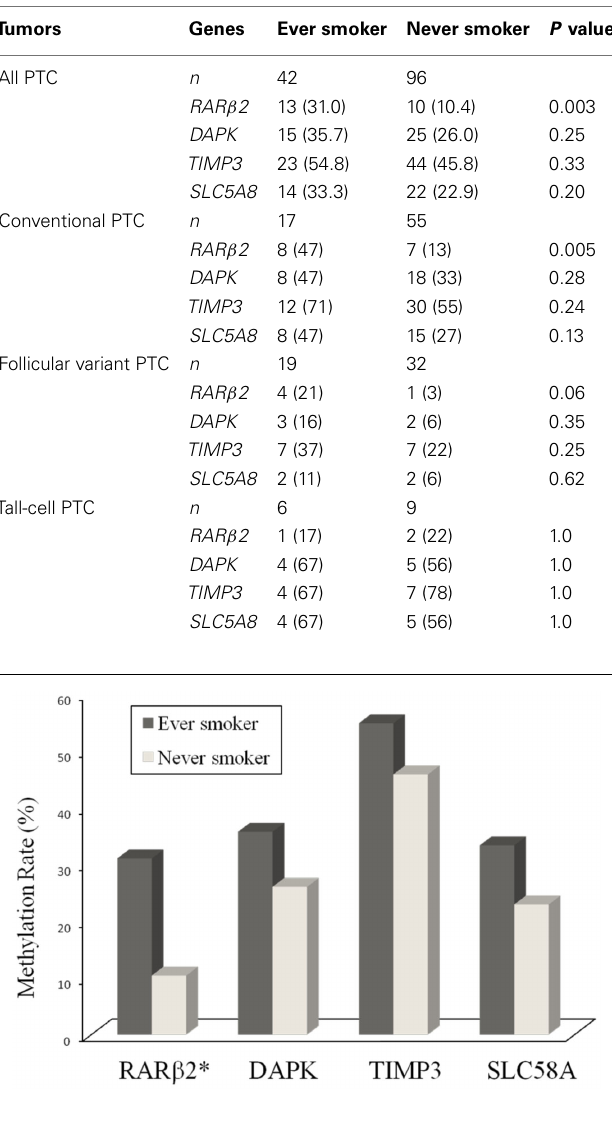
FIGURE 1 |Aberrant gene methylation in papillary thyroid cancer in ever and never smokers. Shown on y -axis is the methylation rate – percentage of the methylation-positive cases (%) – for each of the four genes indicated on the x -axis. *The methylation rate of the RAR β 2 gene is significantly higher ( P = 0.003) in the ever smoker group than the never smoker group.The methylation rate for the remaining three genes shows a higher trend for ever smokers but does not reach statistical significance.